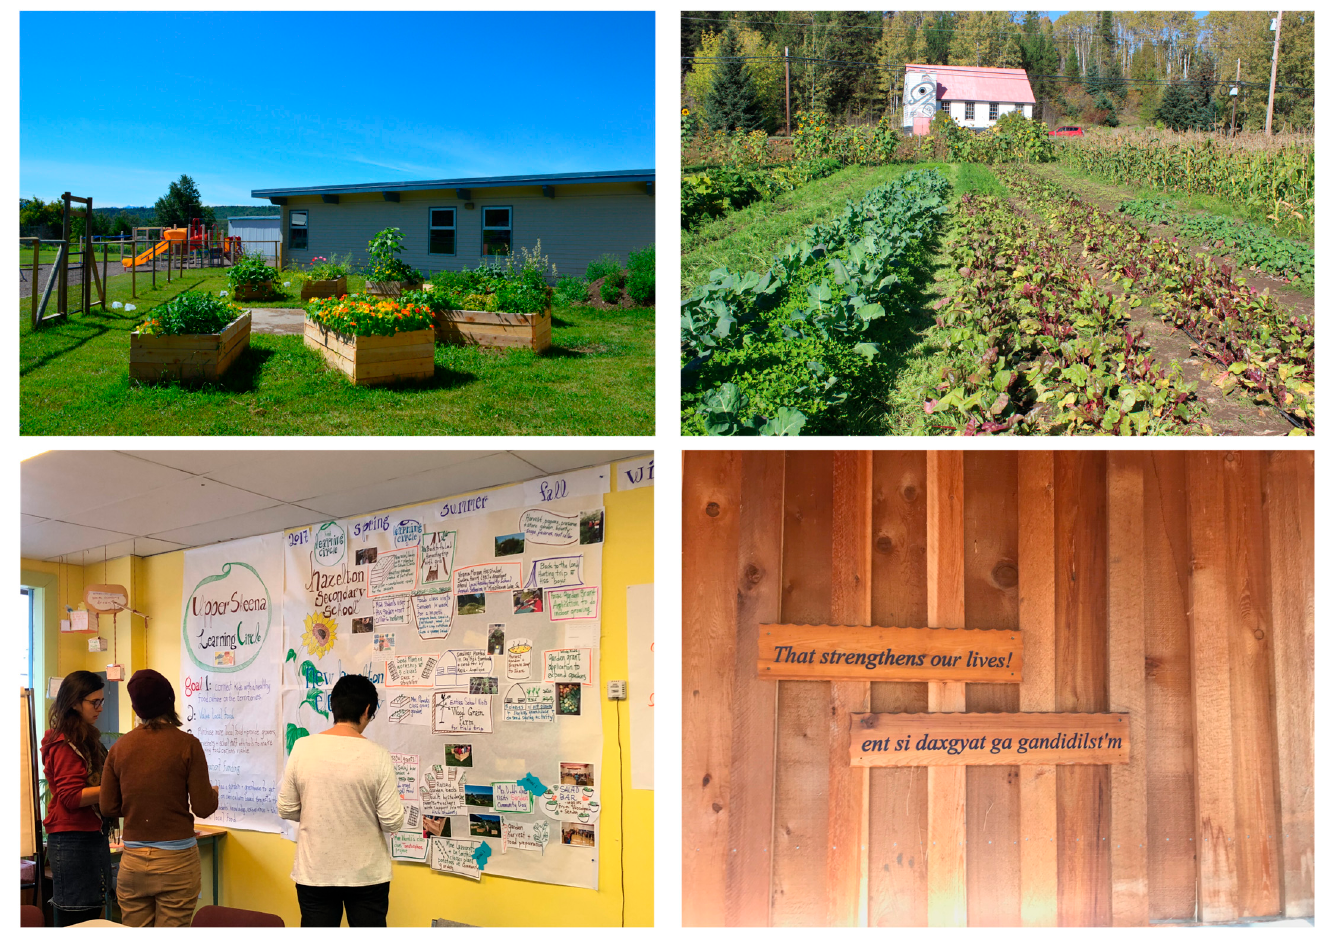
Figure 1. Images from Hazelton/Upper Skeena. Clockwise from top left: MGA school garden; Senden Farm; Sign outside HSS smokehouse; Developing goals during a LC in 2017.